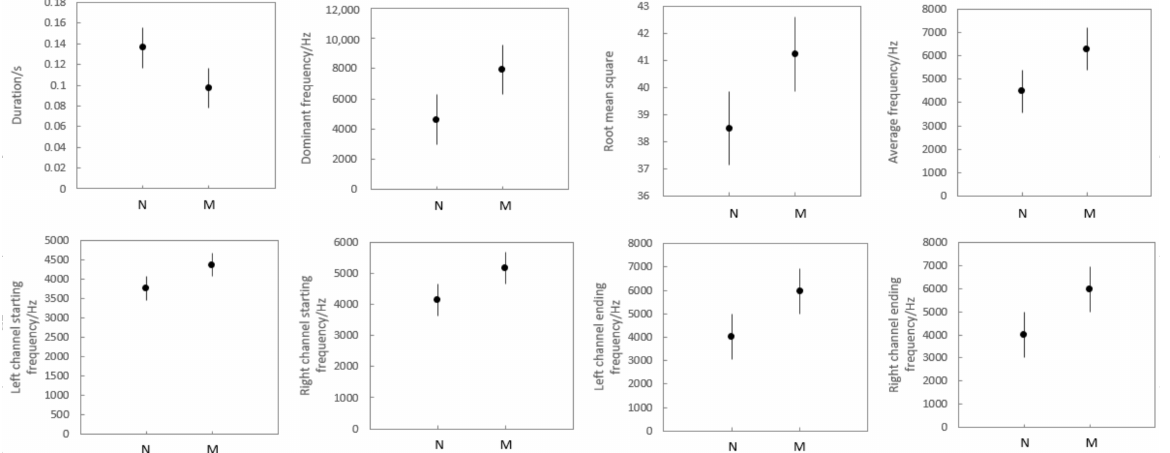
Figure 6. Average ± SE of two kinds of alarm call information. On all graphs: N = natural without disturbance; M = model disturbance. Sample sizes: N = 26; M =